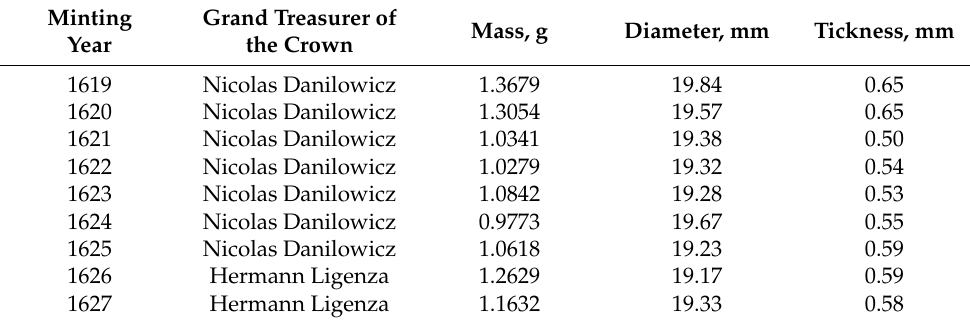
Table 1. Coins physical